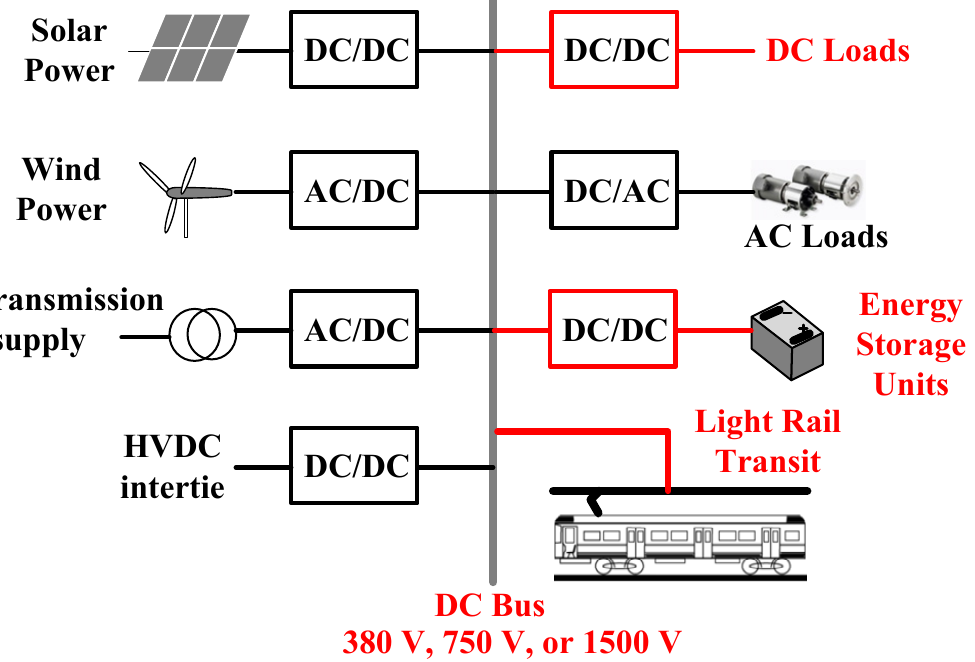
Figure 1. Simplified circuit schematic of a DC microgrid system.